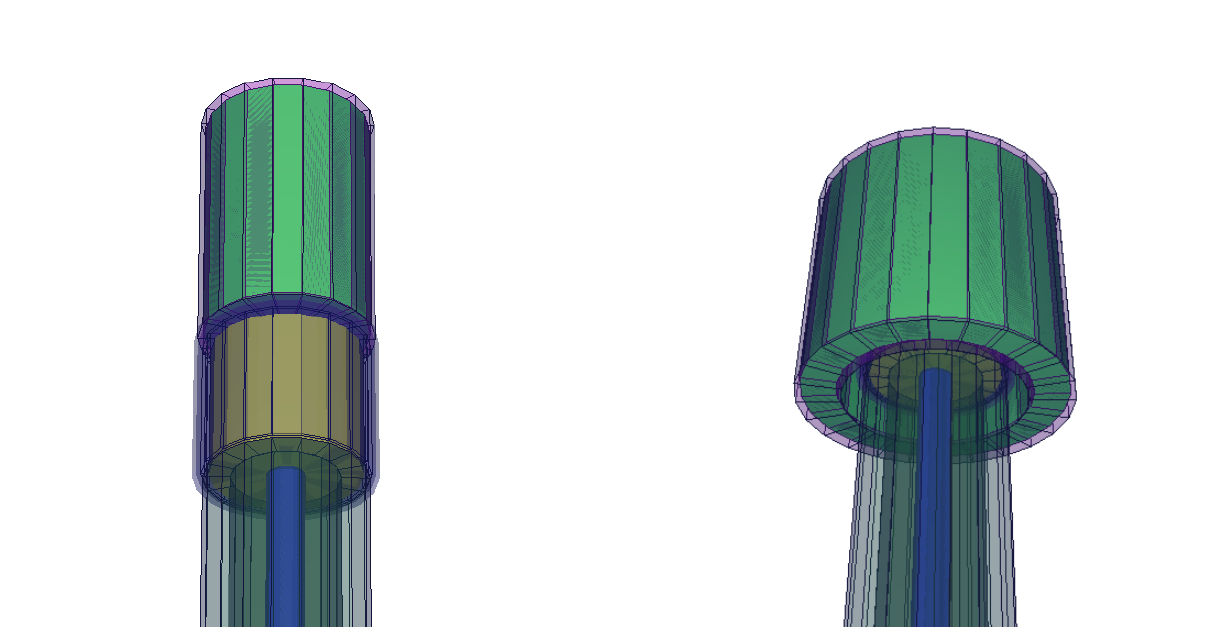
Figure 1. 3D visualization of detector model. Yellow inner part is the crystal, the top green part represents the M600 (right) and M280 (left) container, blue part is the cooling finger.